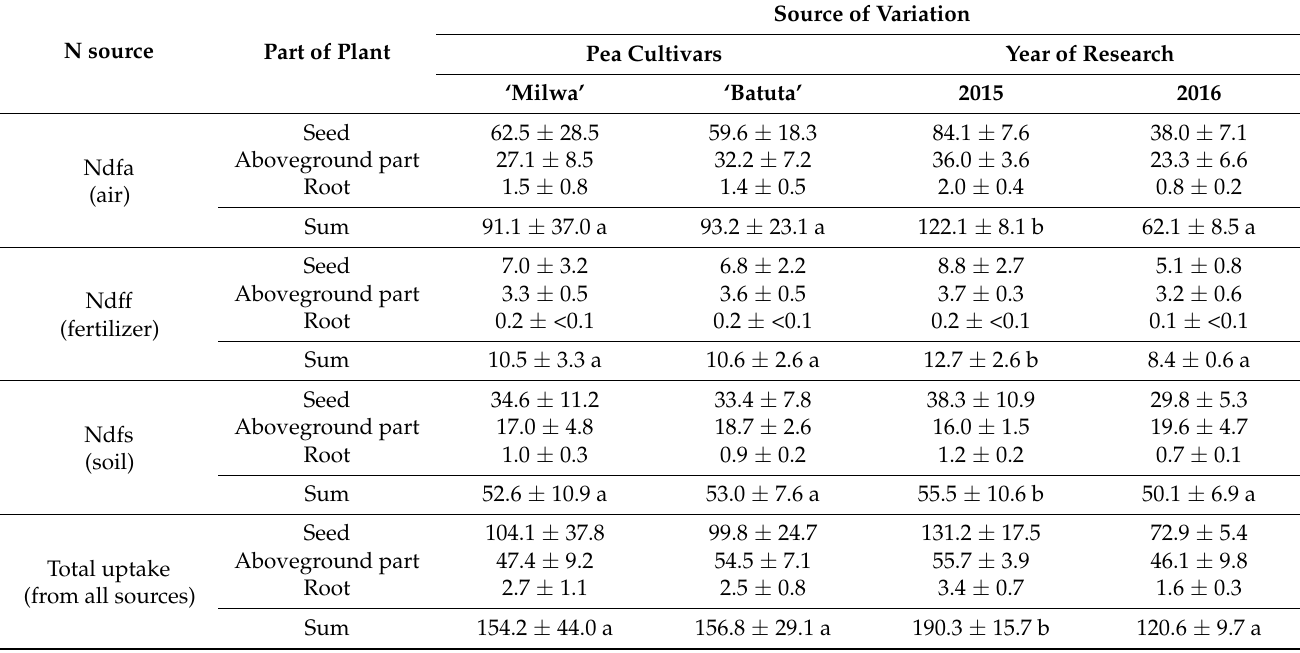
Table 8. Nitrogen uptake from different sources by pea at BBCH stage 90, kg N · ha − 1 (means for cultivars, and for years of research from three replications ±